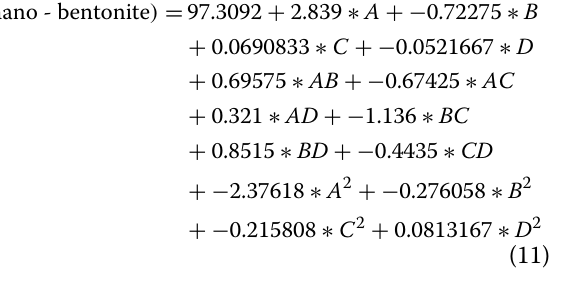
Table 3. The second-order response surface polynomial function [Eqs. (11) and (12)] can be used to predict the dye’s optimum operating circumstances: